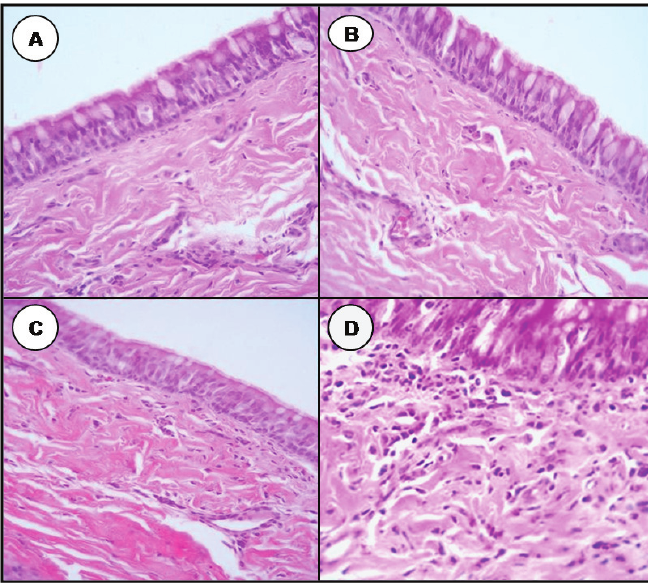
FIGuRE 3 - Medial trachea. Mild PMN infiltrate in the lamina propria ( A and B ; LMA group, x40); Moderate PMN infiltrate in the lamina propria ( C and d ; TT group, x40 e x60, respectively). Light microscopy